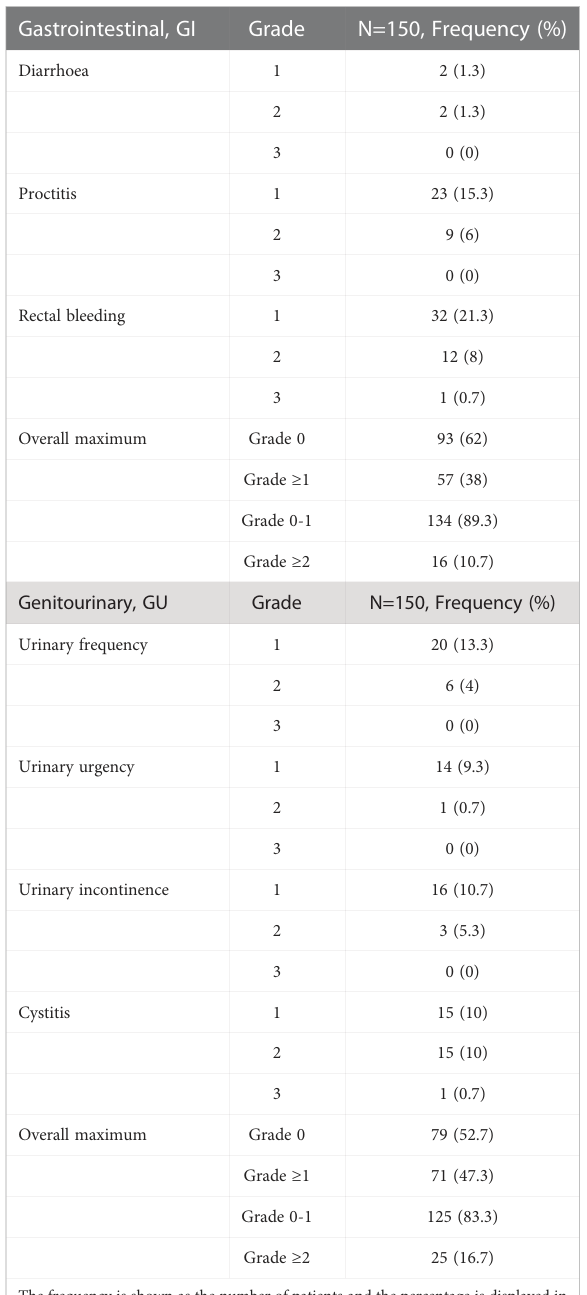
TABLE 1 Late toxicity pro fi les of 150 patients with HR-PCa. Gastrointestinal,